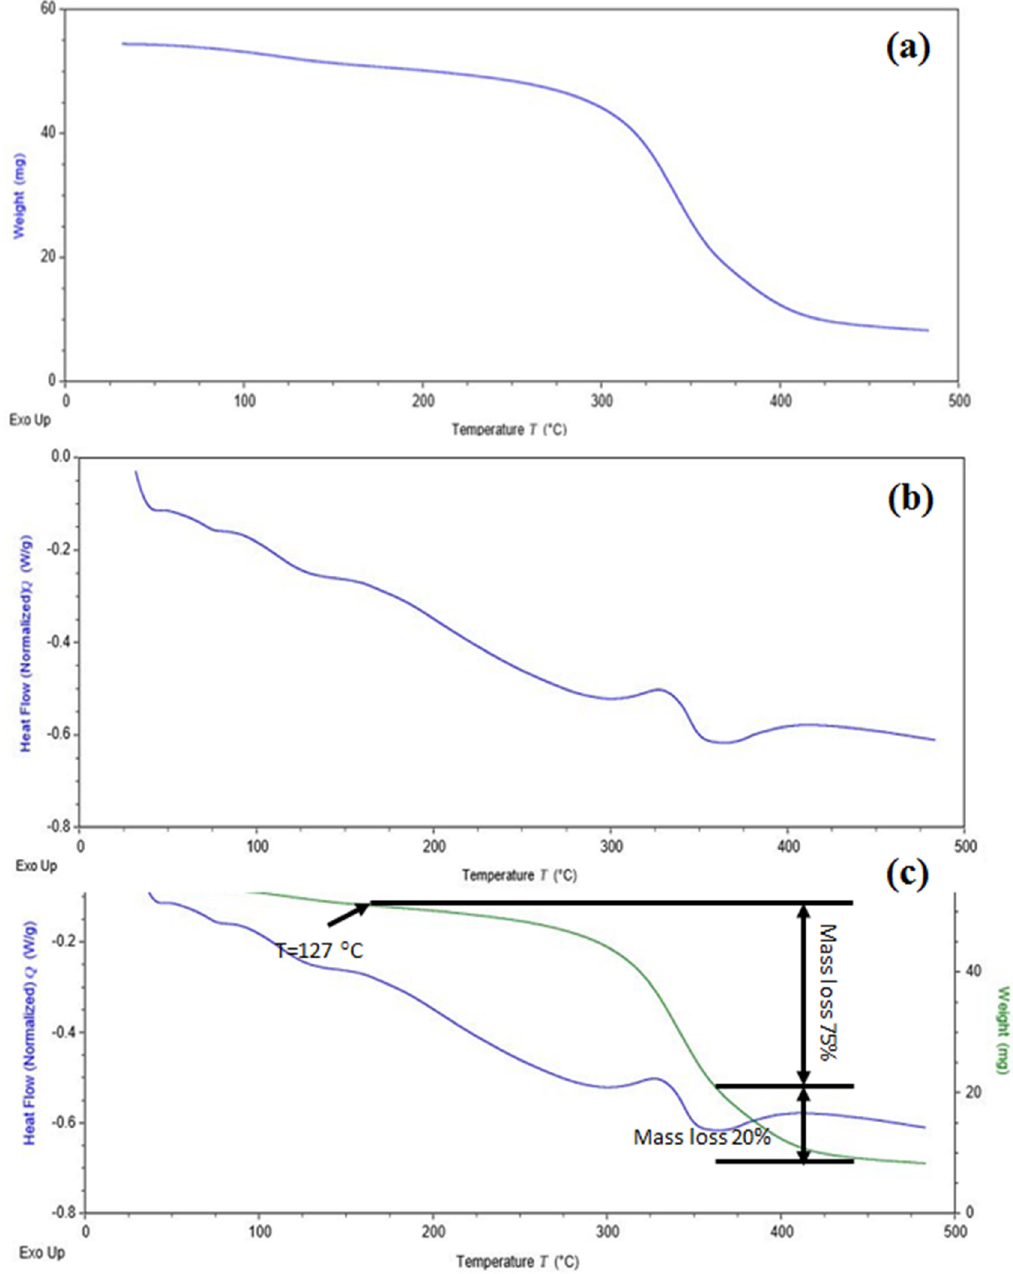
Figure 9. Thermal analysis of the JCJC spent tea leaf composites: ( a ) TGA curves, ( b ) DSC curves, and ( c ) TGA and DSC combined